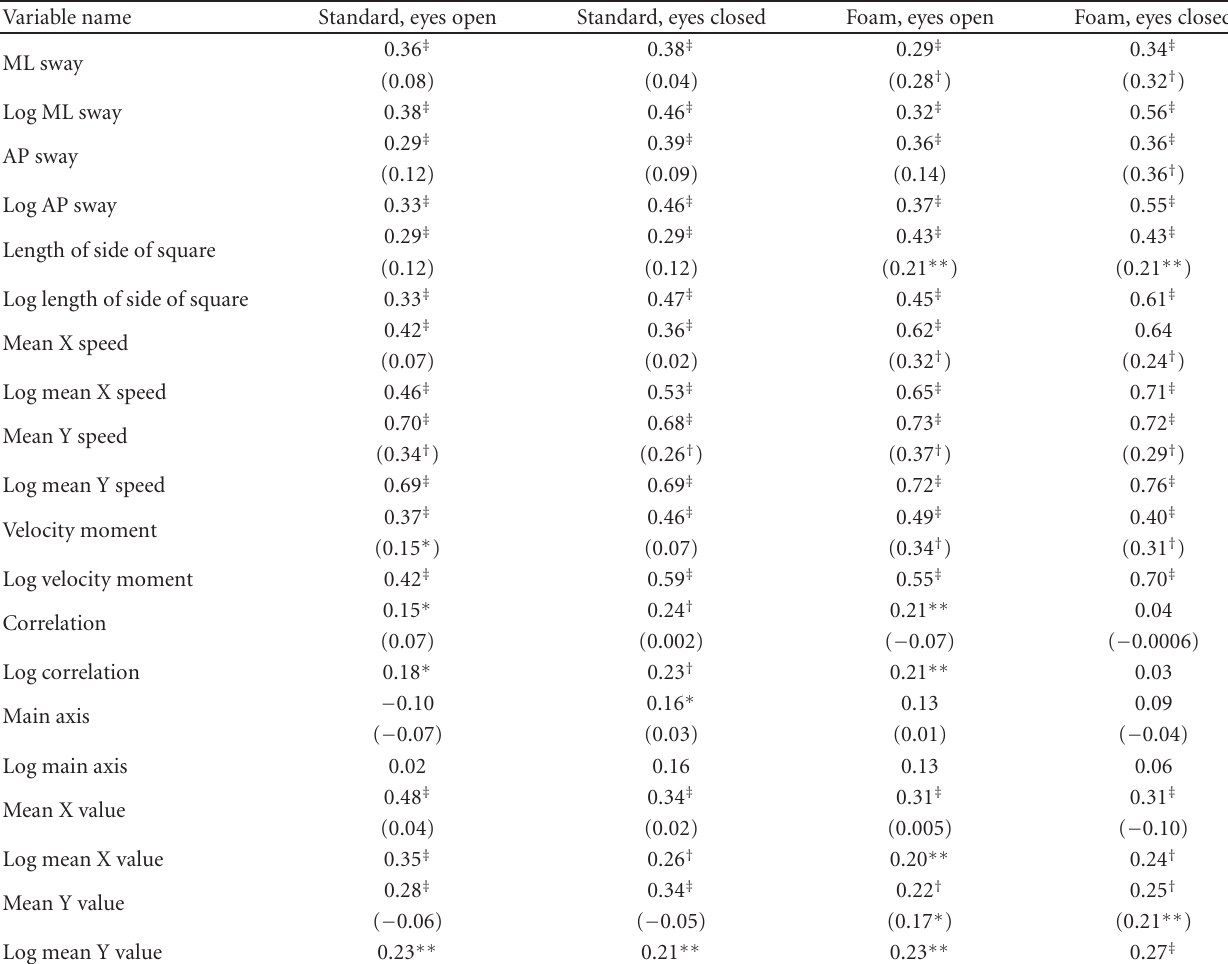
Table 5: Balance platform—test-retest reliability N =